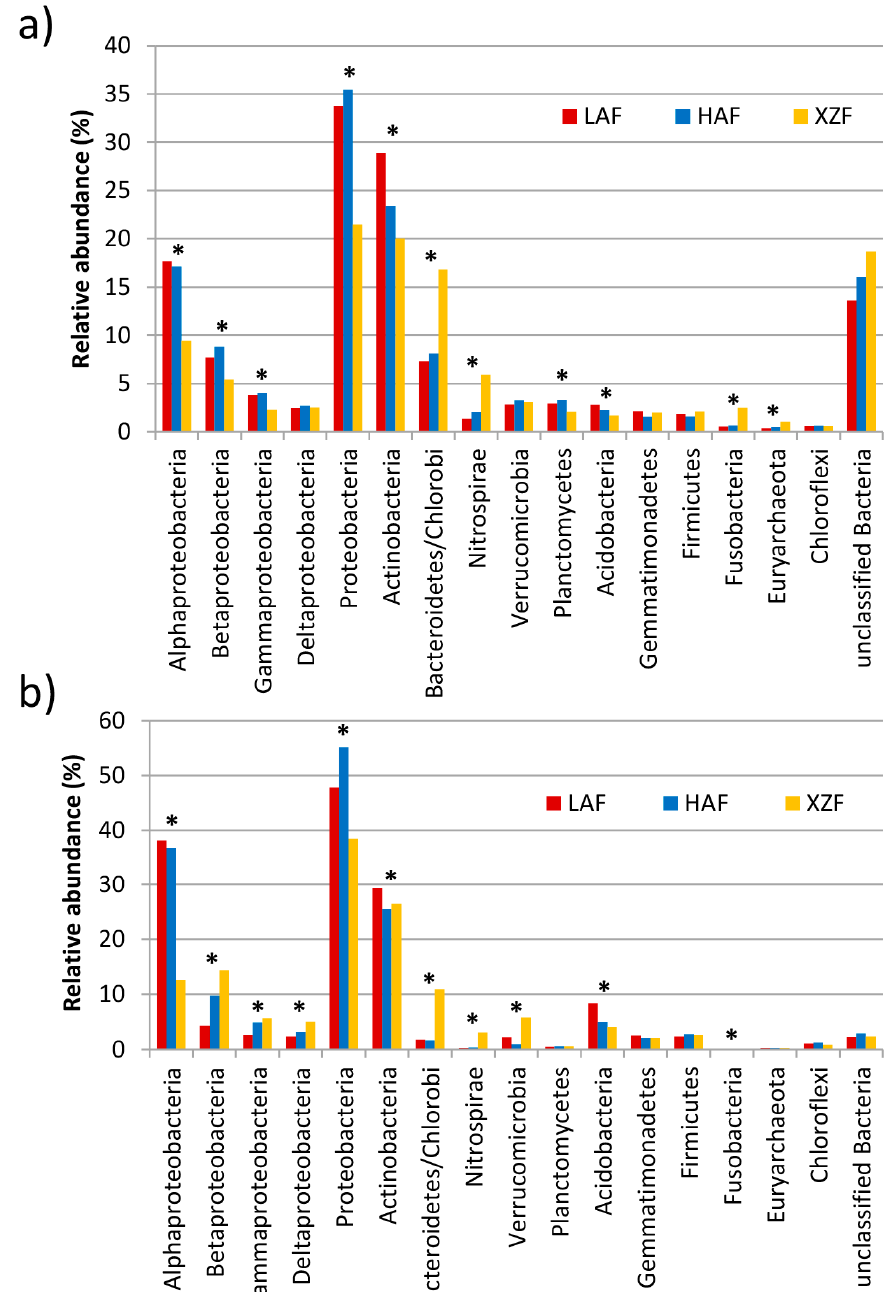
Figure 1. Taxonomic and phylogenetic assignment of reads at the phylum and class levels. ( a ) Taxonomic classification of SSU rRNA sequences by BLASTN against the SILVA database using Classifier v2.3 software; ( b ) Phylogenetic classification of the total contigs datasets annotated on the KO database, performed by BLASTX analysis against the Greengenes genome database using the IMG/JGI web server. The Y axis represents the relative abundance of each taxon expressed as a percentage. Phyla and Proteobacteria classes with more than 1% relative abundance on at least one of the datasets are plotted. Taxonomical groups with statistically significant differences between samples are marked with an asterisk.